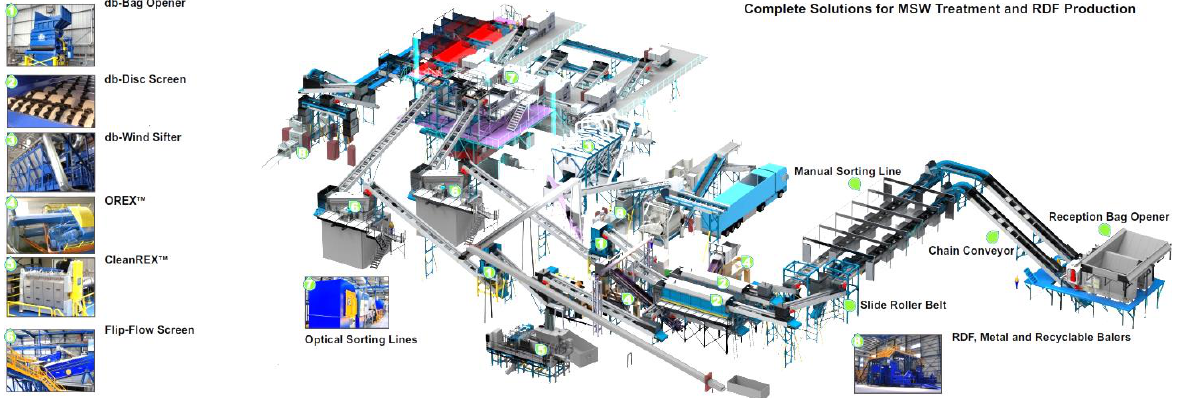
Figure 5. Recovering organics and recyclables from MSW and wet commercial waste. The authors originally produced the figure.